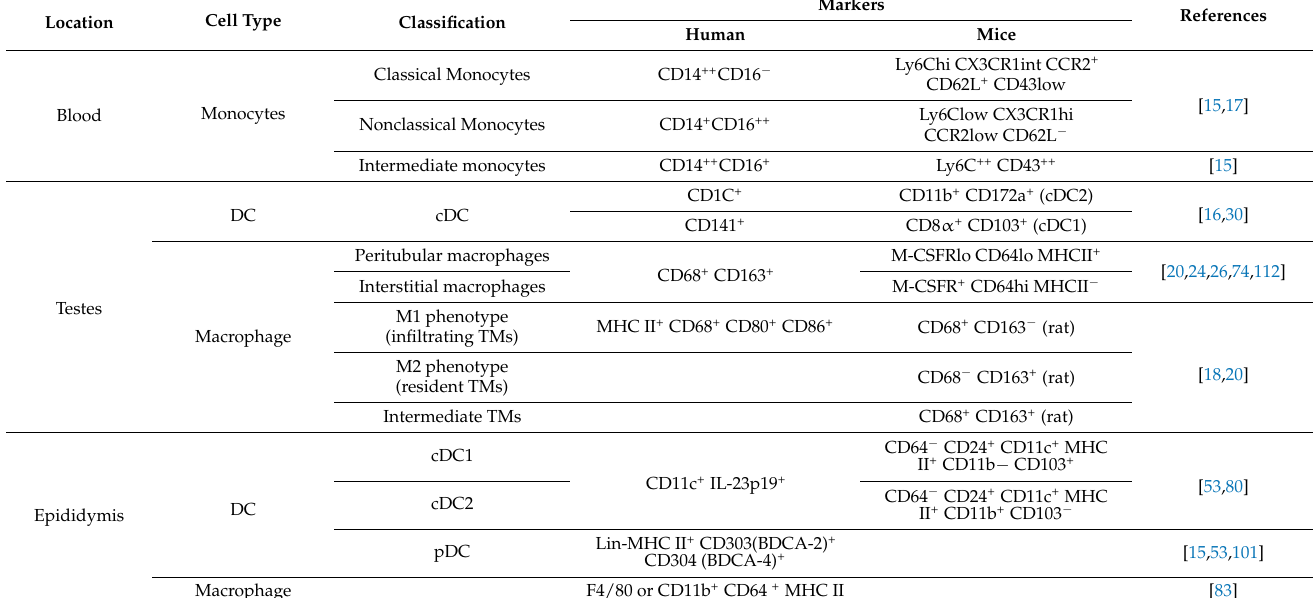
Table 1. T Cell-surface markers used to identify MPS in testes and